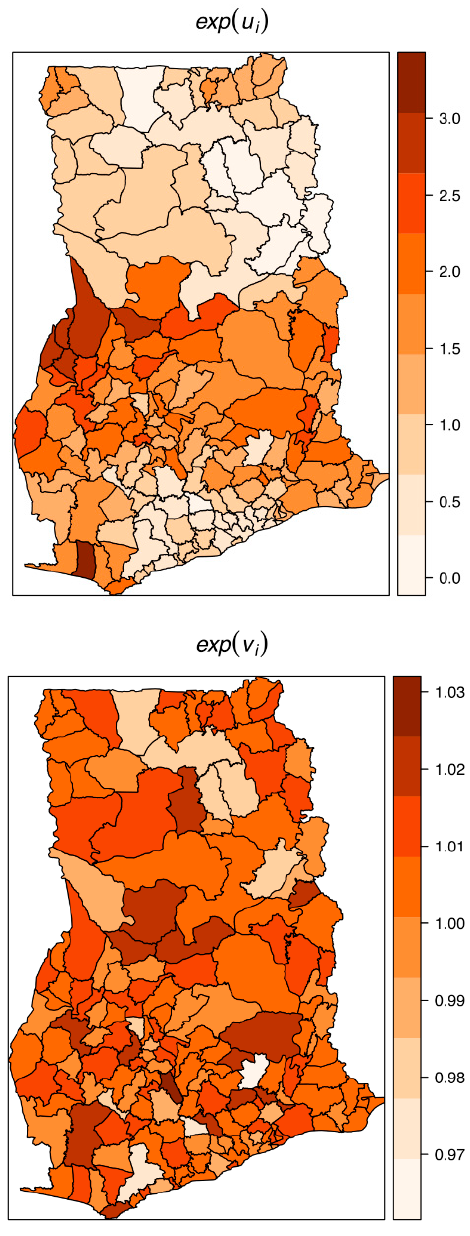
Figure 6. Residual spatial variation of the structured or clustering (top) and the unstructured or heterogeneity (below) after accounting for relevant covariates, temporal effects, and space-time effects.